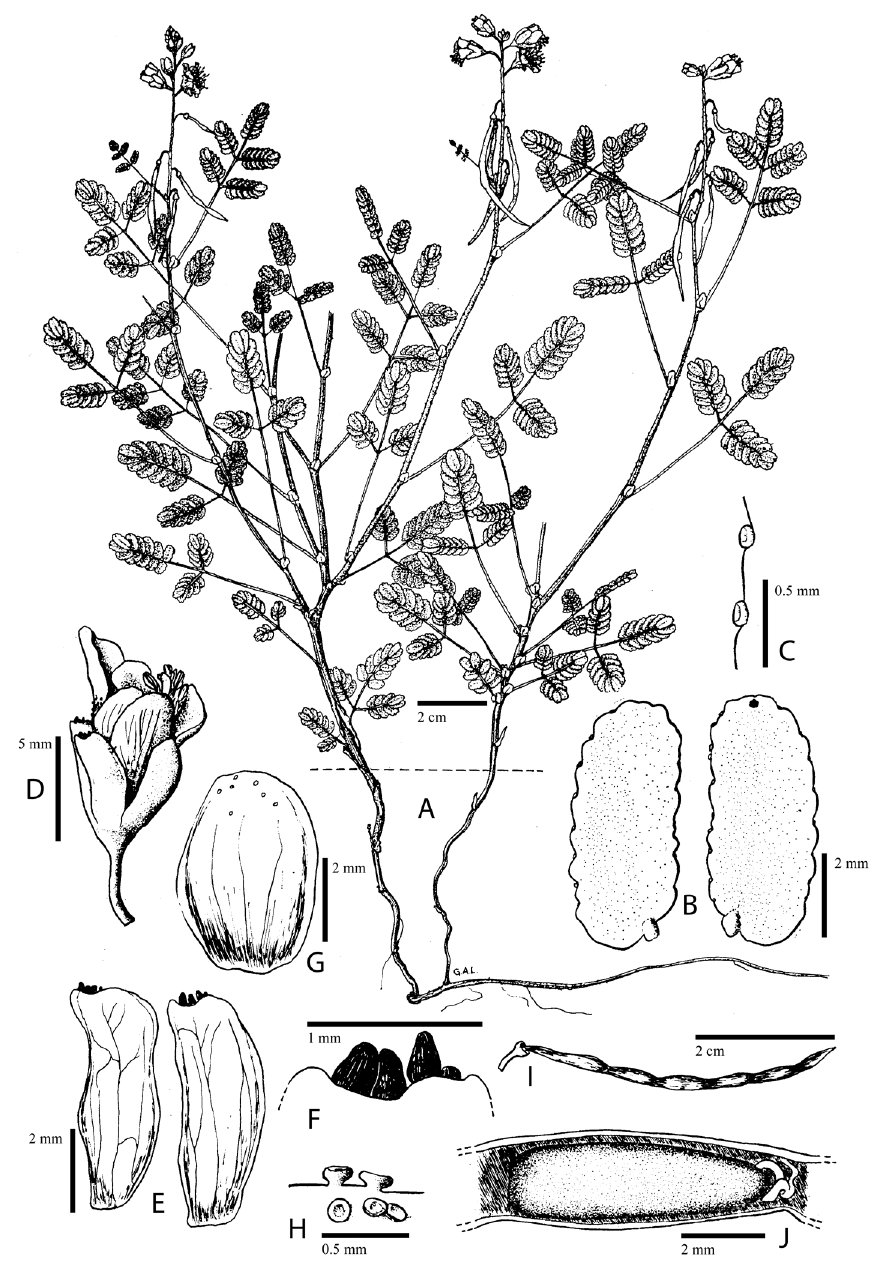
Figure 36. Stenodrepanum bergii Harms. A habit B leaflets C glands on the margin of the leaflets D flower E sepals with glands F apical glands of the sepals G lower cucullate sepal H glands on the petals I fruit J position of a seed in the fruit. A – H from Piccini-Leguizamon 1970 I, J from Soriano 787. A drawn by G. A. Larsen, B–J drawn by Emilio A. Ulibarri, originally published in Darwiniana , vol. 21 (nos. 2–4), page 402